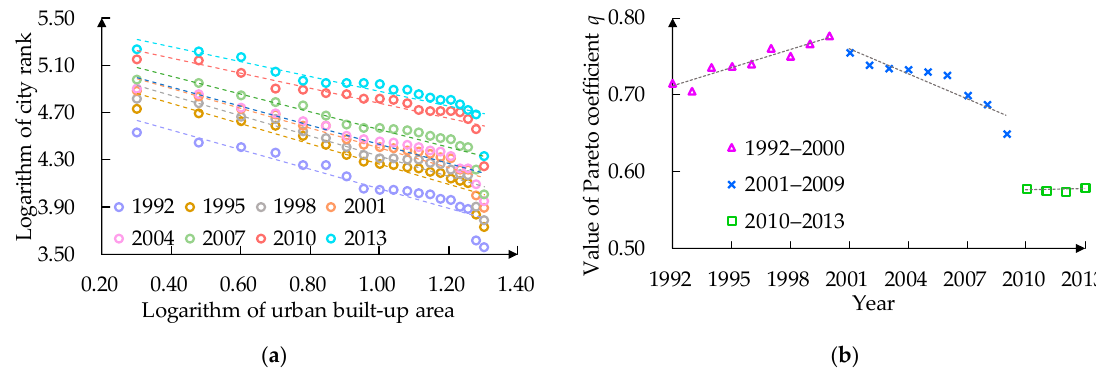
Figure 5. Temporal changes of the urban rank-size distribution and Pareto coefficient ( q ) in the WTSUA from 1992 to 2013. ( a ) change trend of the urban rank-size distribution; ( b ) change trend of Pareto coefficient ( q ).